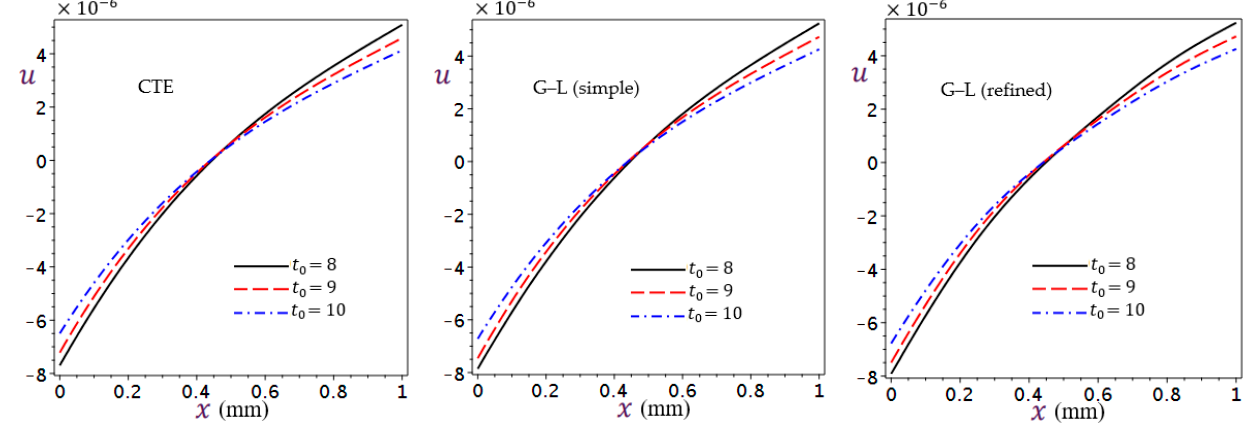
Figure 7. Effect of ramp-type heating parameter t 0 on displacement u .